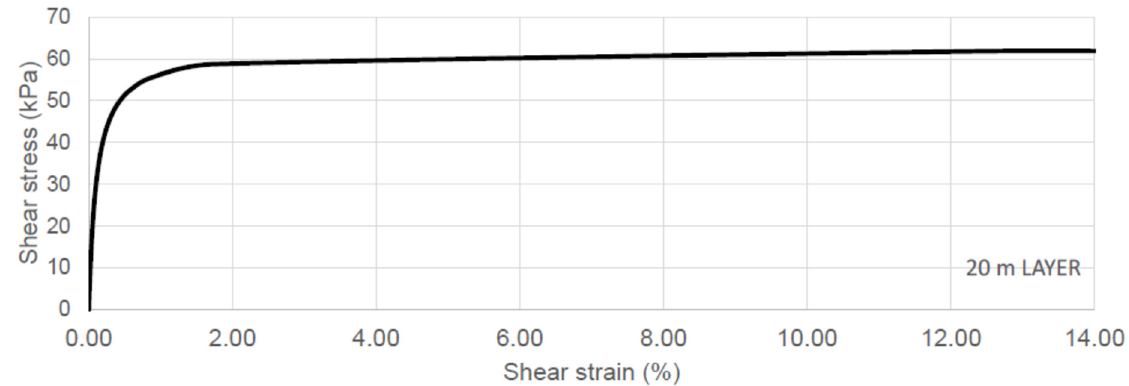
Figure 4. Backbone curve (20 m layer).